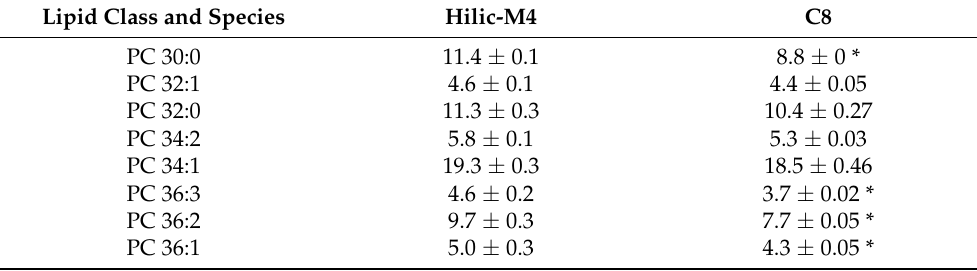
Table 6. Comparison of phospholipid concentration ( µ g/mL) of milk (Milk-11) determined by RP-LC-MS and